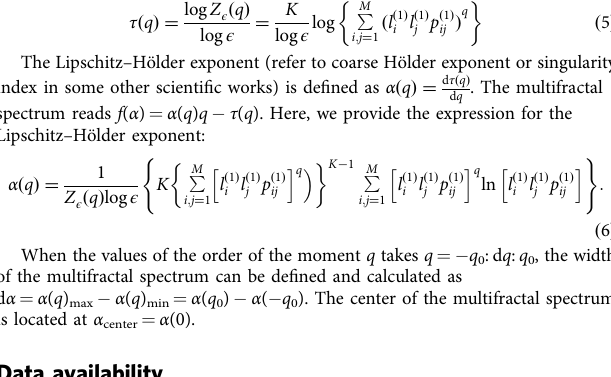
Algorithm 1: Reconstructing the WMGM through a variational EM